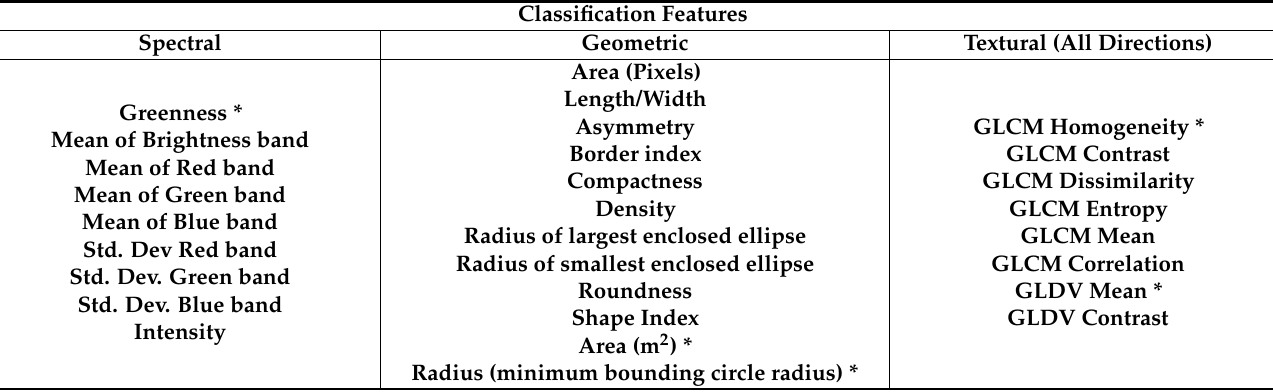
Table 2. Individual tree crown features (parameters) derived from both eCognition and ArcGIS software tools. Classification